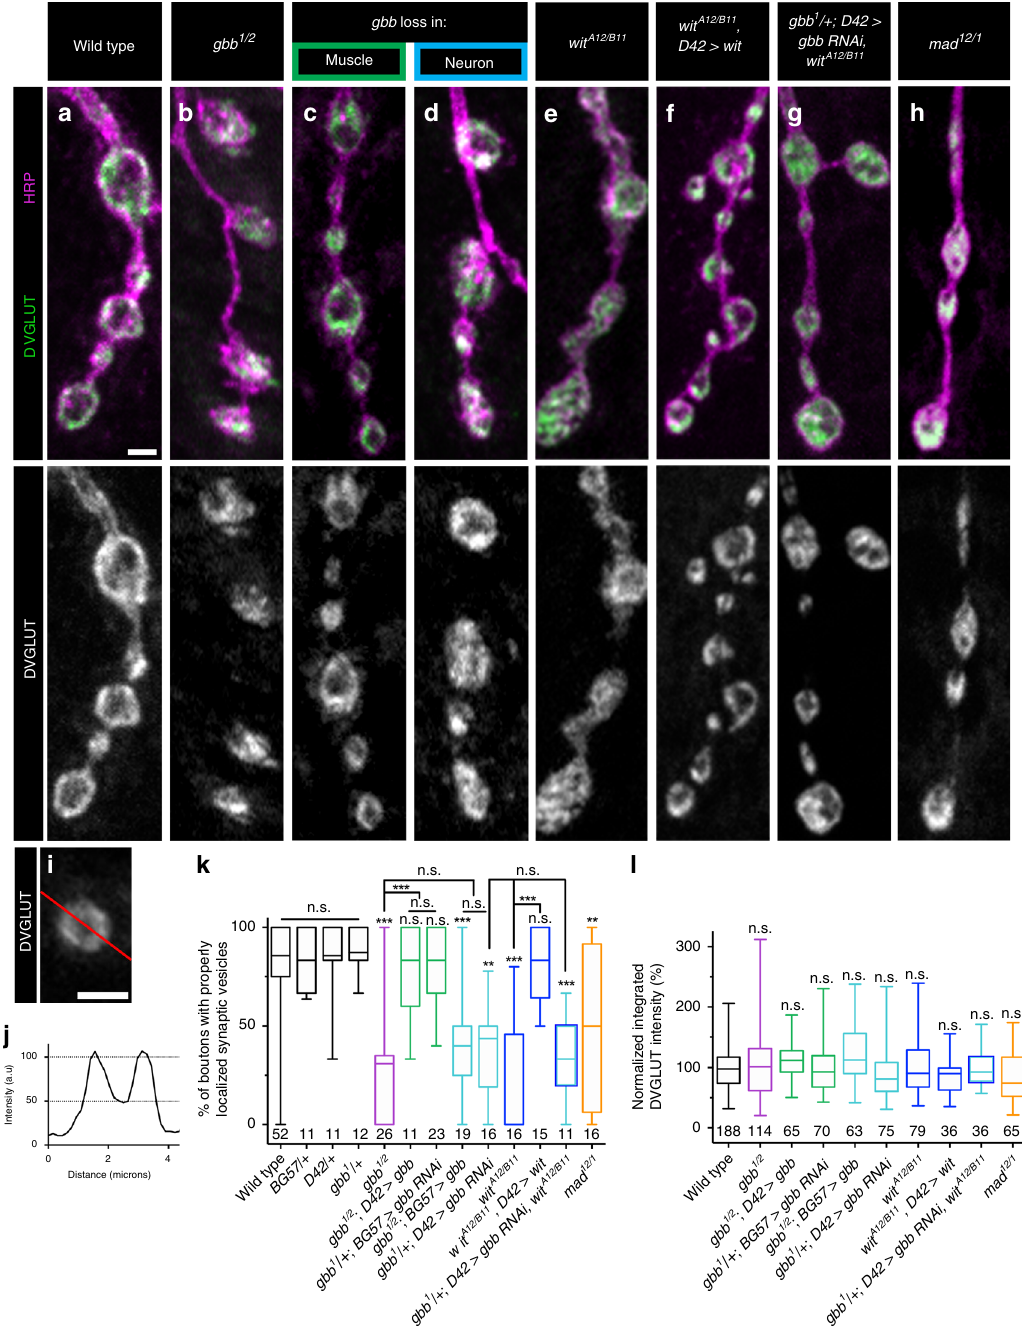
Fig. 3 Presynaptic BMP signaling regulates SSV distribution. a – h Representative z -projections of boutons of the indicated genotypes labeled with DVGLUT (green) and HRP (magenta). gbb loss in muscle is gbb 1/2 ; D42>gbb , and gbb loss in neuron is gbb 1/2 ; BG57>gbb . Scale bar: 2 µ m. i The red line represents a typical line drawn through a bouton larger than 2 µ m in diameter. Scale bar: 2 µ m. j The fl uorescence intensity graph along the line ( i ) was created as shown. If the two intensity maxima were each greater than twice the minimum, the bouton had properly distributed synaptic vesicles. k Quanti fi cation of the percentage of boutons properly distributed synaptic vesicles. For all DVGLUT localization analyses, n is the number of NMJs scored. l Quanti fi cation of integrated DVGLUT intensity normalized to controls. For all integrated DVGLUT analyses, n is the number of boutons scored. Error bars are min and max data points, and the center line indicates the median. n.s. not signi fi cantly different. ** p < 0.01; *** p < 0.001. All tests are nonparametric Kruskal – Wallis one-way ANOVAs on ranks followed by Dunn ’ s multiple comparison